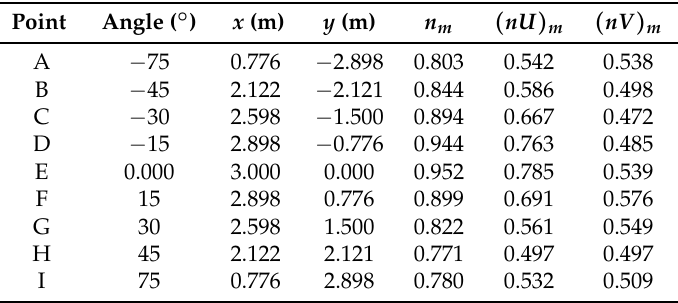
Table 1. Test Parameters: n 0 = 1.0 (non-dimensionalized), S 0 = 1.2, n b / n 0 = 0.8, S b = 0.8, α 0 = 45 ◦ , T 0 = 200 Kelvin, T b = 300 Kelvin. Number densities and fluxes are normalized by n 0 and n 0